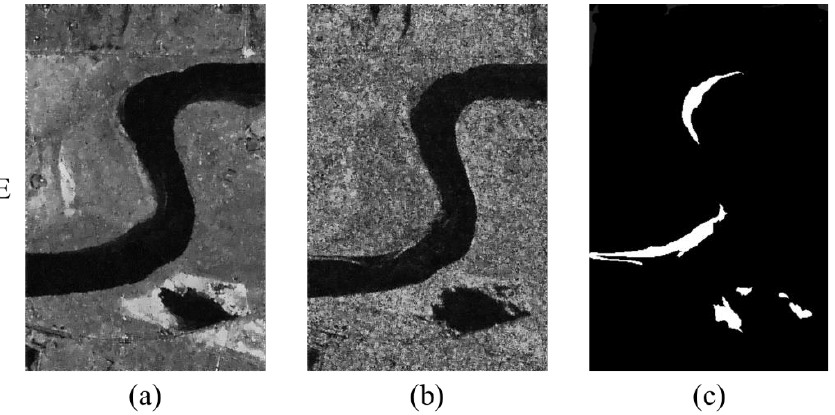
Figure 9. Yellow River B Dataset. ( a ) Image acquired in June 2008. ( b ) Image acquired in June 2009. ( c ) Ground-truth map.